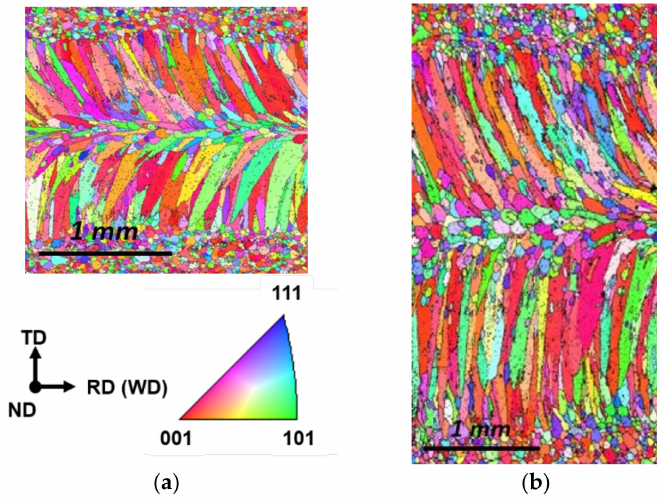
Figure 5. Electron backscatter diffraction (EBSD) analysis with and without laser beam oscillation. Specimen was prepared under laser power of 900 W at welding speed of 3 m/min. ( a ) linear welding; ( b ) oscillation welding with oscillation width of 1.6 mm at 200